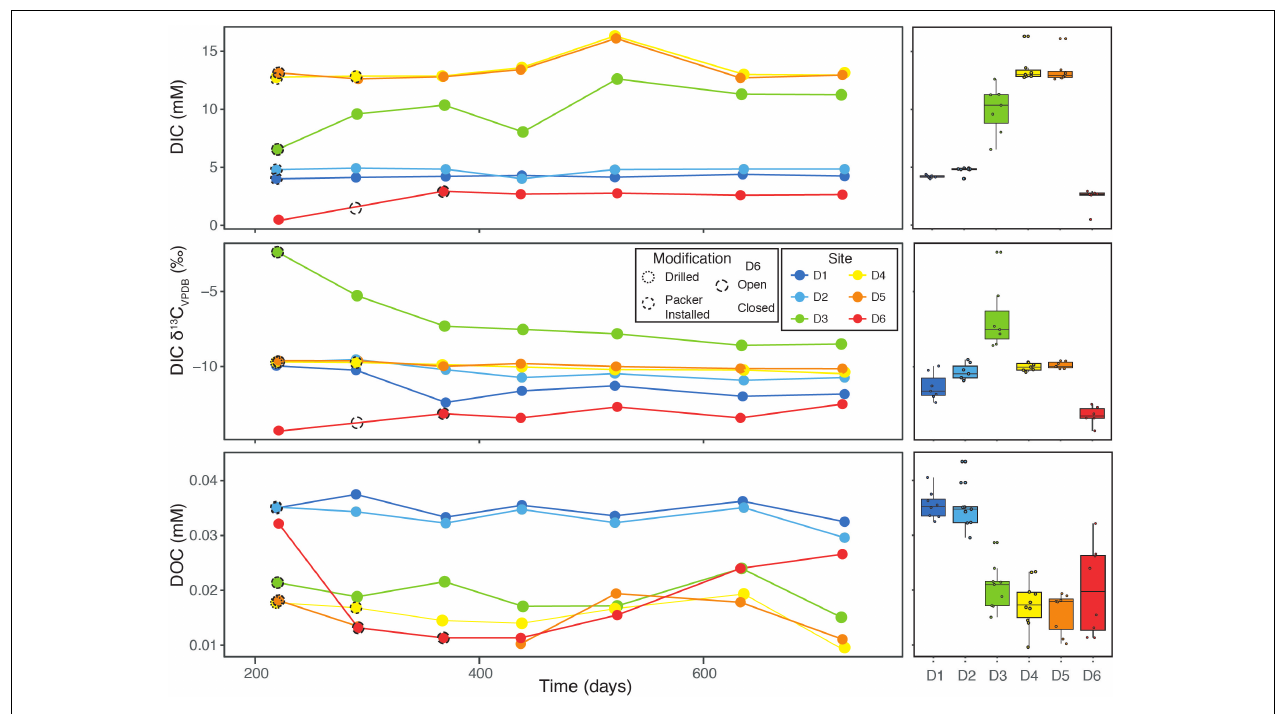
FIGURE 7 | Box and line plots of DIC, δ 13 C DIC , and